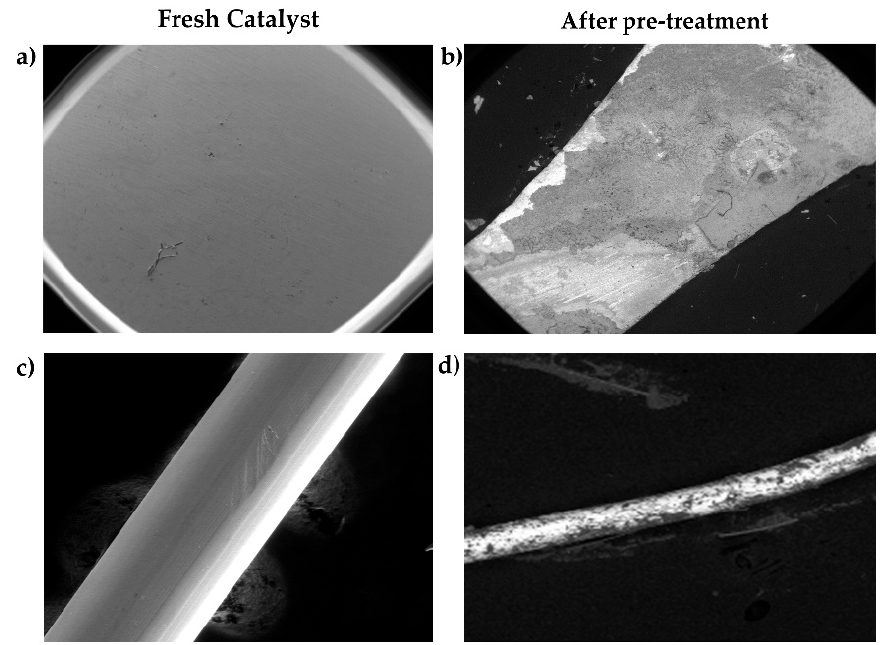
Figure 5. SEM images of the Cu Plate ( a ) fresh and ( b ) after being pre-treated and Cu Wire ( c ) fresh and ( d ) after being pre-treated.